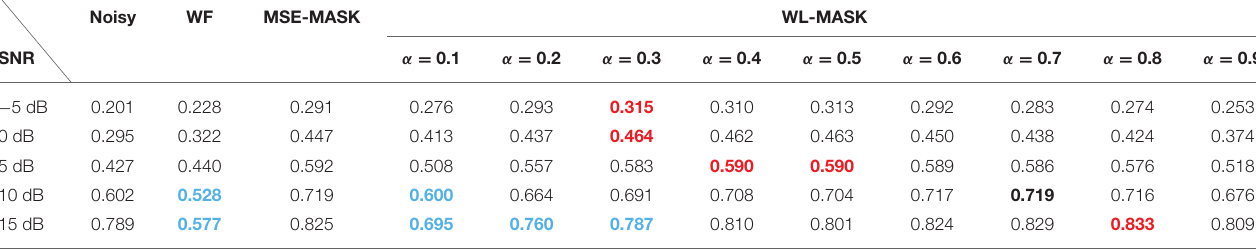
TABLE 2 | The mean ECM score results for different systems under Babble. Noisy WF MSE-MASK WL-MASK SNR α =